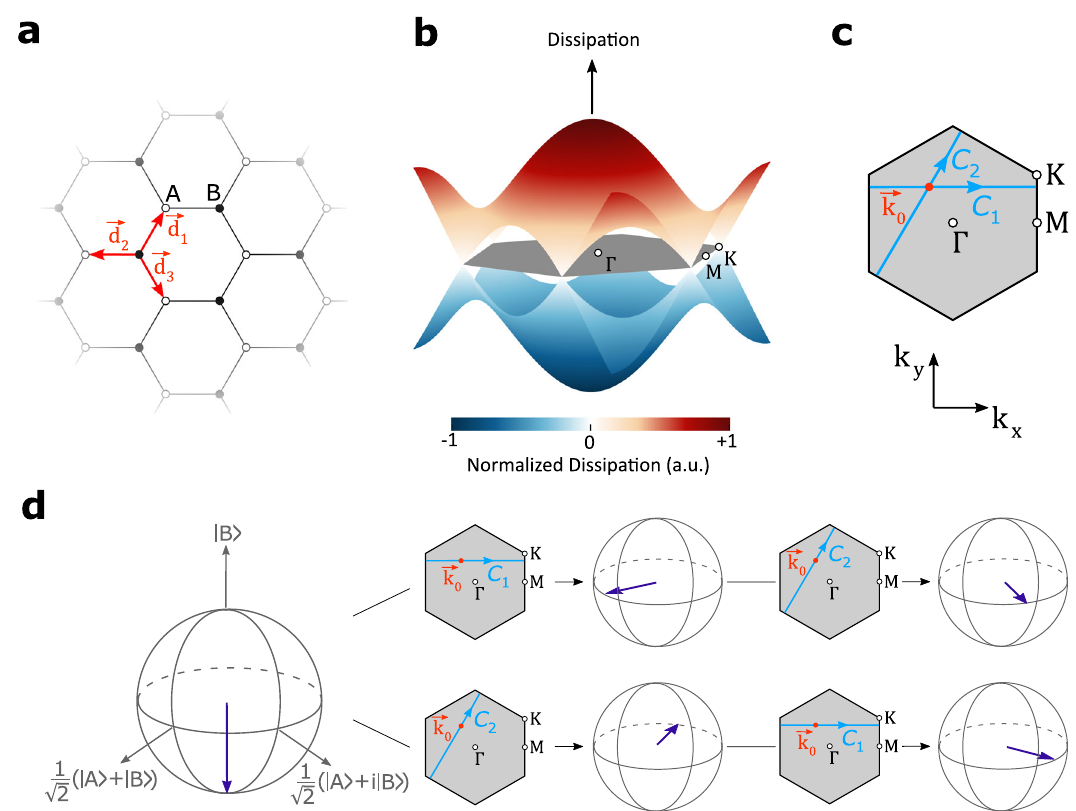
Fig. 5 | Non-Abelian dynamics involving Bloch eigenstates in a dissipative honeycomb lattice. a Schematic of a dissipative honeycomb lattice with two sublattices A and B . b DissipationbandsassociatedwiththeBlocheigenstatesofthe lattice. c TheBrillouinzoneinthereciprocalspacewhereaninitialpointat k = k 0 is